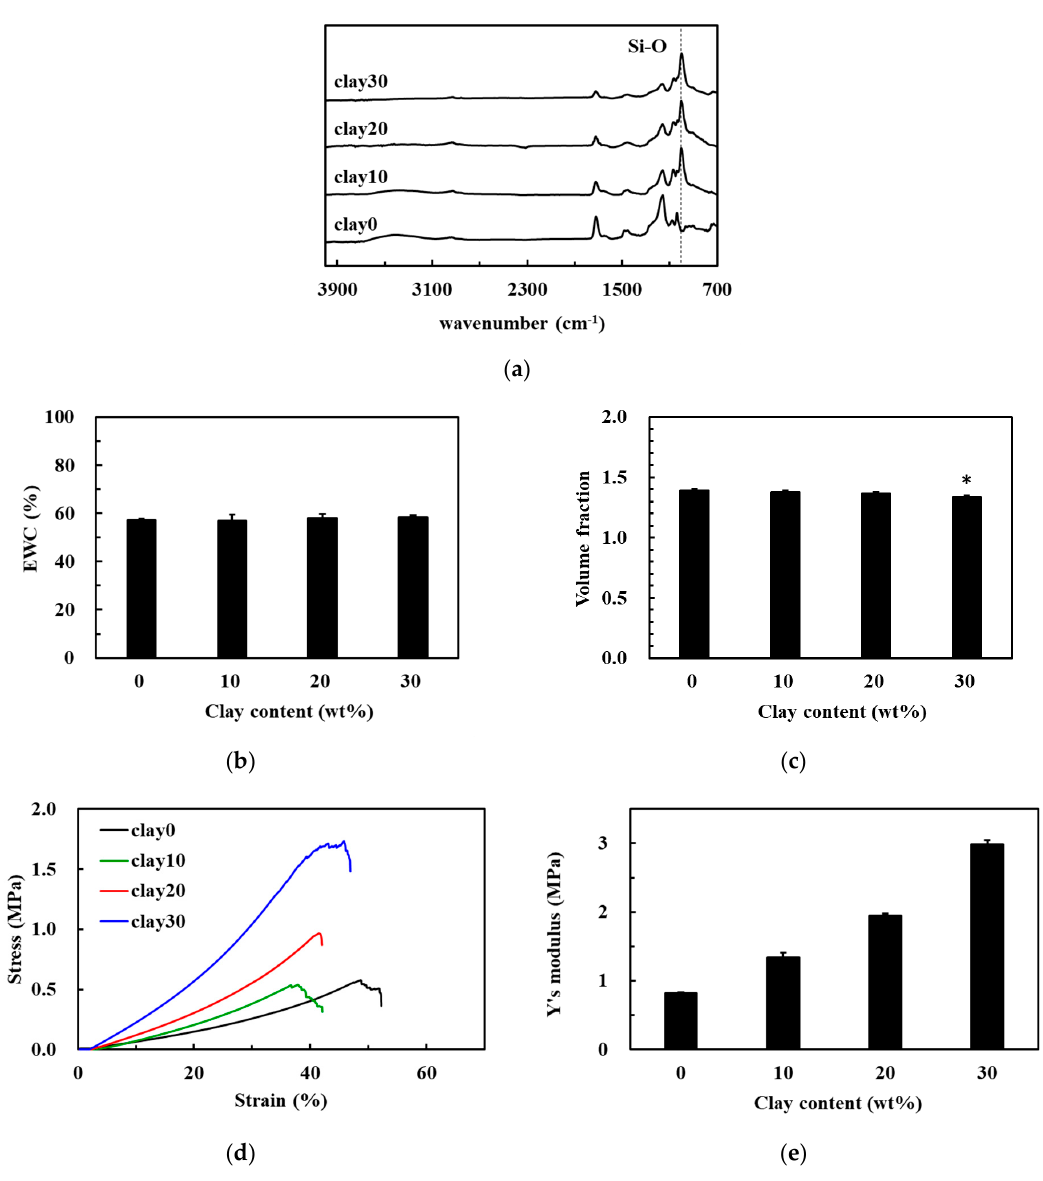
Figure 4. Preparation of hybrid HEMA/SBMA nanocomposite hydrogels. ( a ) FTIR analysis of the nanocomposite hydrogels. The percentage of EWC ( b ) and the volume fraction ( c ) as functions of clay content in the nanocomposite hydrogels. ( d ) The stress-strain curves for the nanocomposite hydrogels produced using various contents of clay. ( e ) Young’s moduli of the nanocomposite hydrogels with various contents of clay. Value = mean ± standard deviation, n = 5. *: p < 0.05 vs clay0.